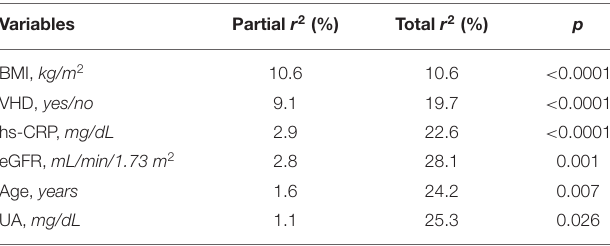
TABLE 5 | Stepwise multiple regression analysis focused on AHI as dependent variable in SA